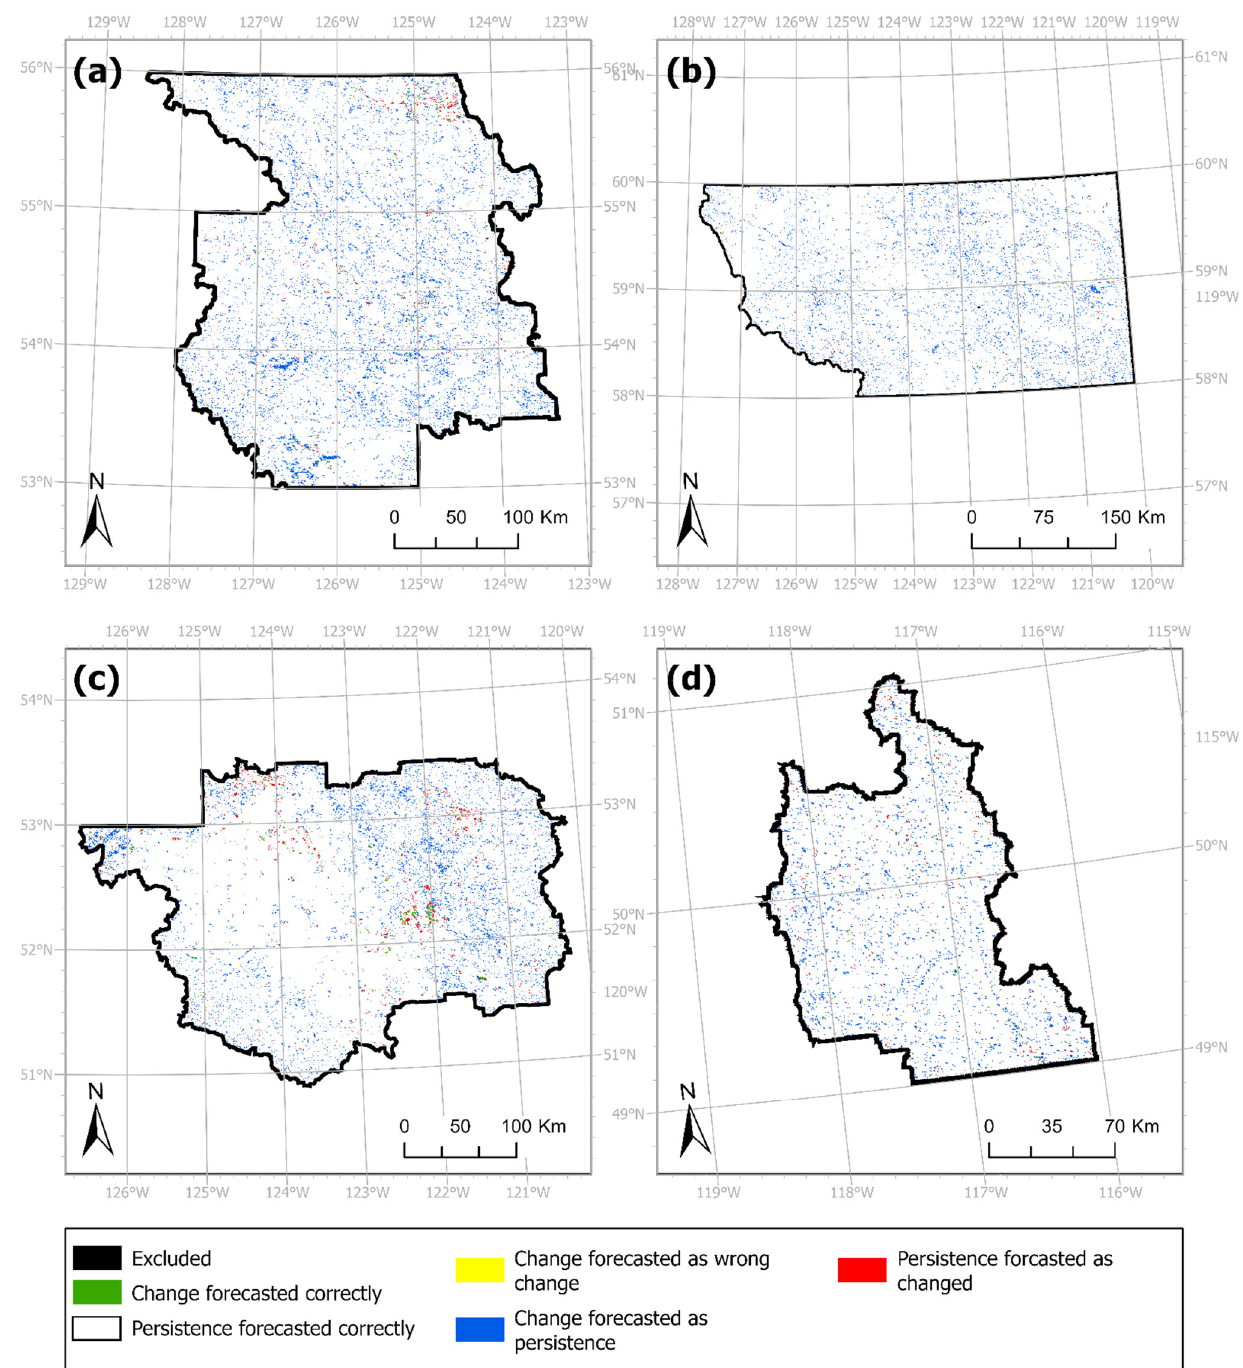
Figure 7. Simulation maps of forecasts with the highest FOM for each region: ( a ) the Regional Dis- trict of Bulkley Nechako forecasted by CNN–TCN 9×9(LC+SVs) , ( b ) the Regional District of Central Koo- District of Bulkley Nechako forecasted by CNN–TCN 9 × 9(LC+SVs) , ( b ) the Regional District of Central tenay forecasted by LSTM 9×9 , ( c ) the Northern Rockies Regional Municipality forecasted by Kootenay forecasted by LSTM 9 × 9 , ( c ) the Northern Rockies Regional Municipality forecasted by TCN 9×9(LC+SVs) , and ( d ) the Cariboo Regional District forecasted by CNN–TCN 9×9(LC+SVs) . TCN 9 × 9(LC+SVs) , and ( d ) the Cariboo Regional District forecasted by CNN–TCN 9 × 9(LC+SVs)